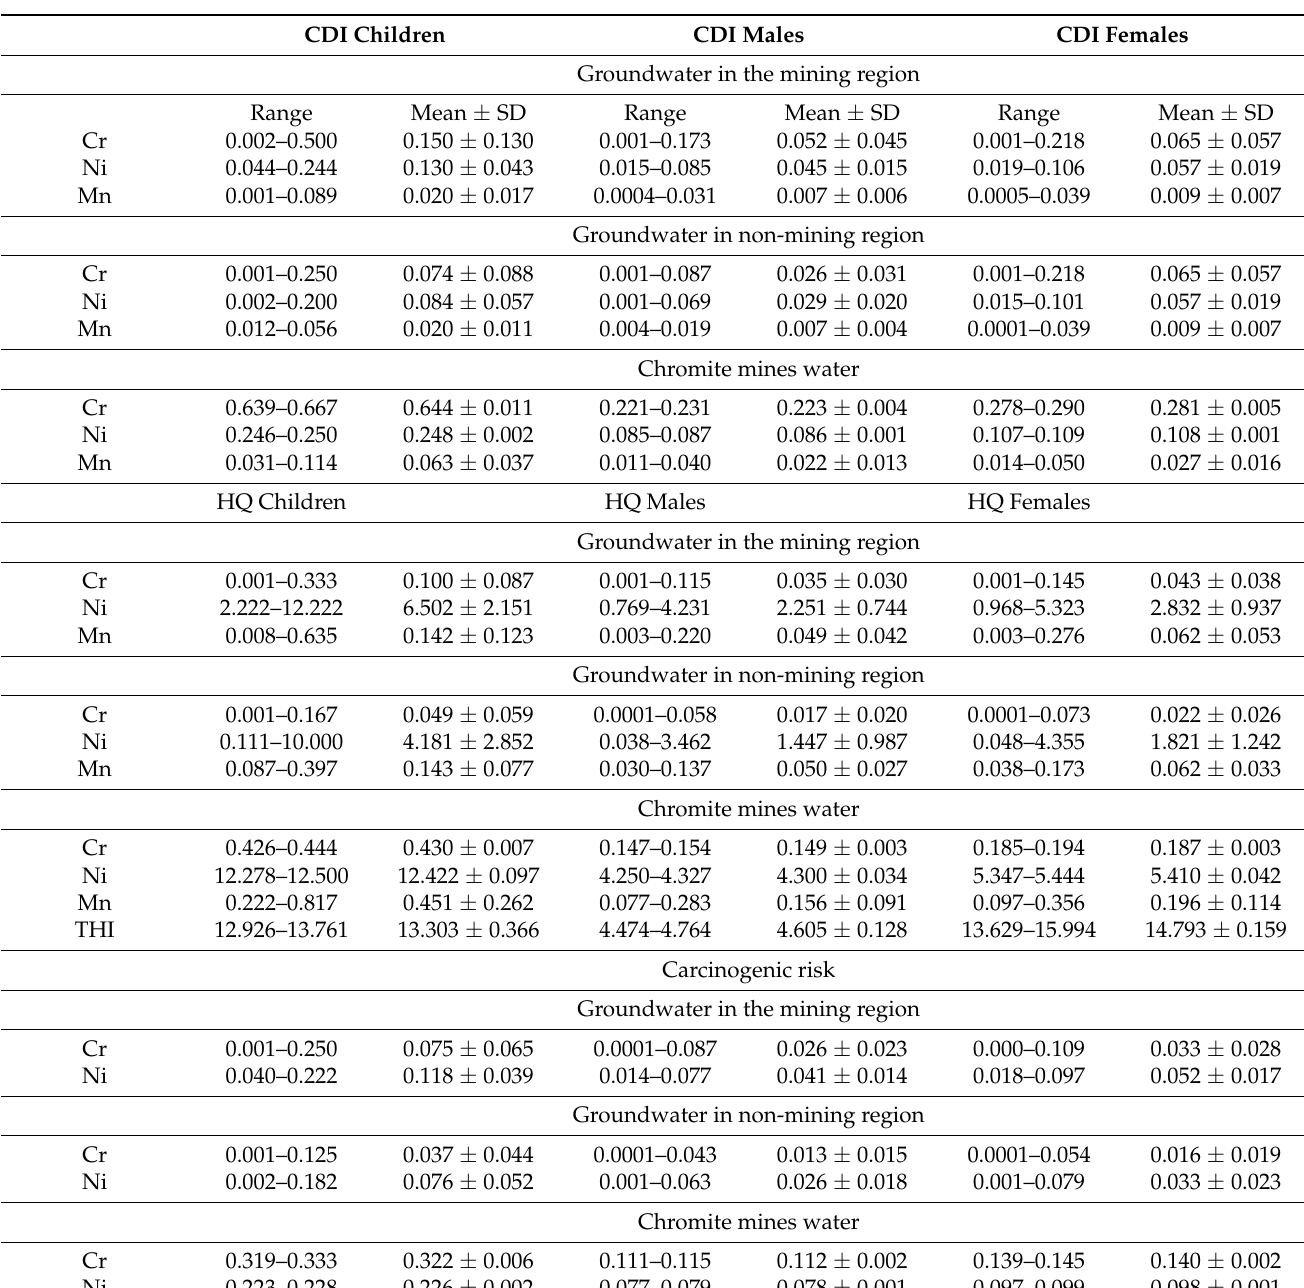
Table 3. Compilation of the non-carcinogenic and carcinogenic risks of consuming HMs such as Cr, Ni, and Mn via oral ingestion of groundwater from mining, non-mining, and chromite mines water in the ultramafic terrain of Malakand, Northern Pakistan. CDI Children CDI Males CDI